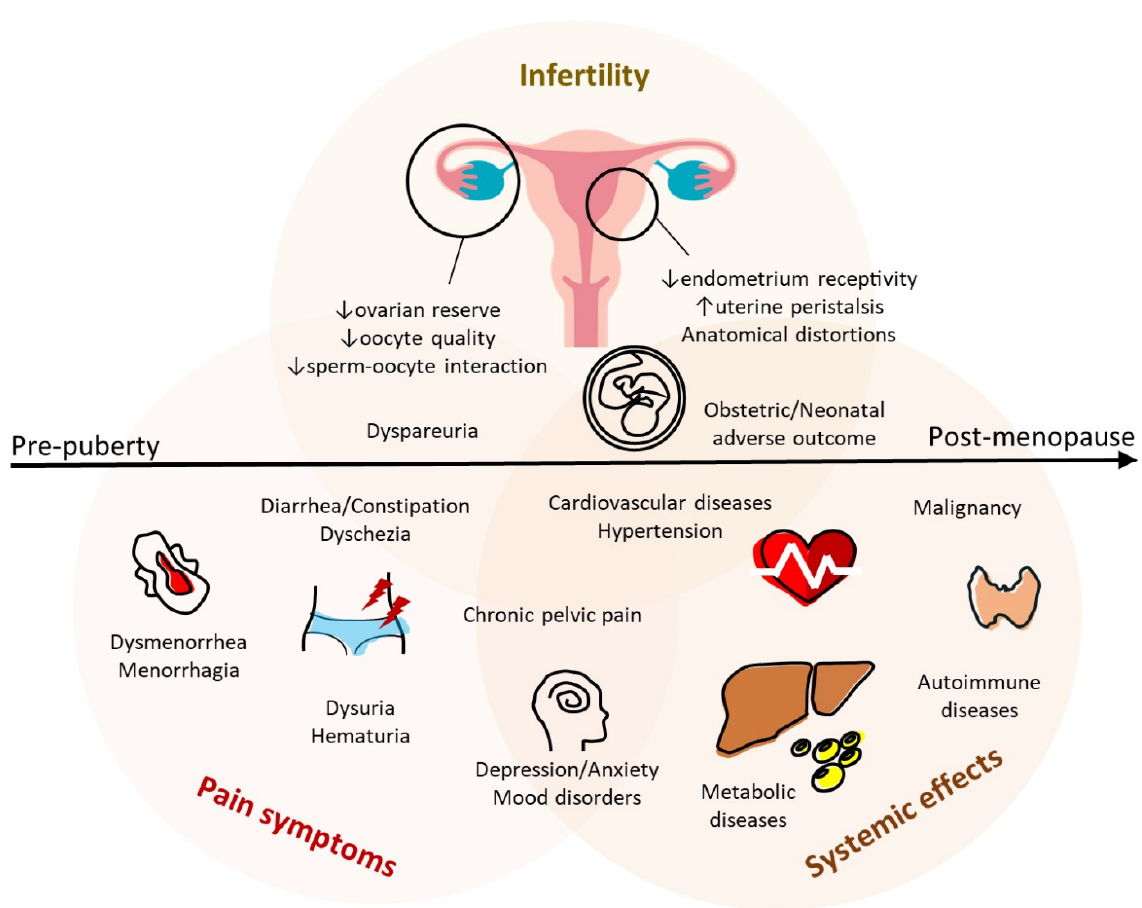
Figure 3. Endometriosis across the life course. Summary of the symptoms associated with endometriosis, including pain, infertility, and systemic effects. They have a wide range of spectrum and can overlap with these other conditions. The upward arrows represent an increase, and the downward arrows represent a decrease.